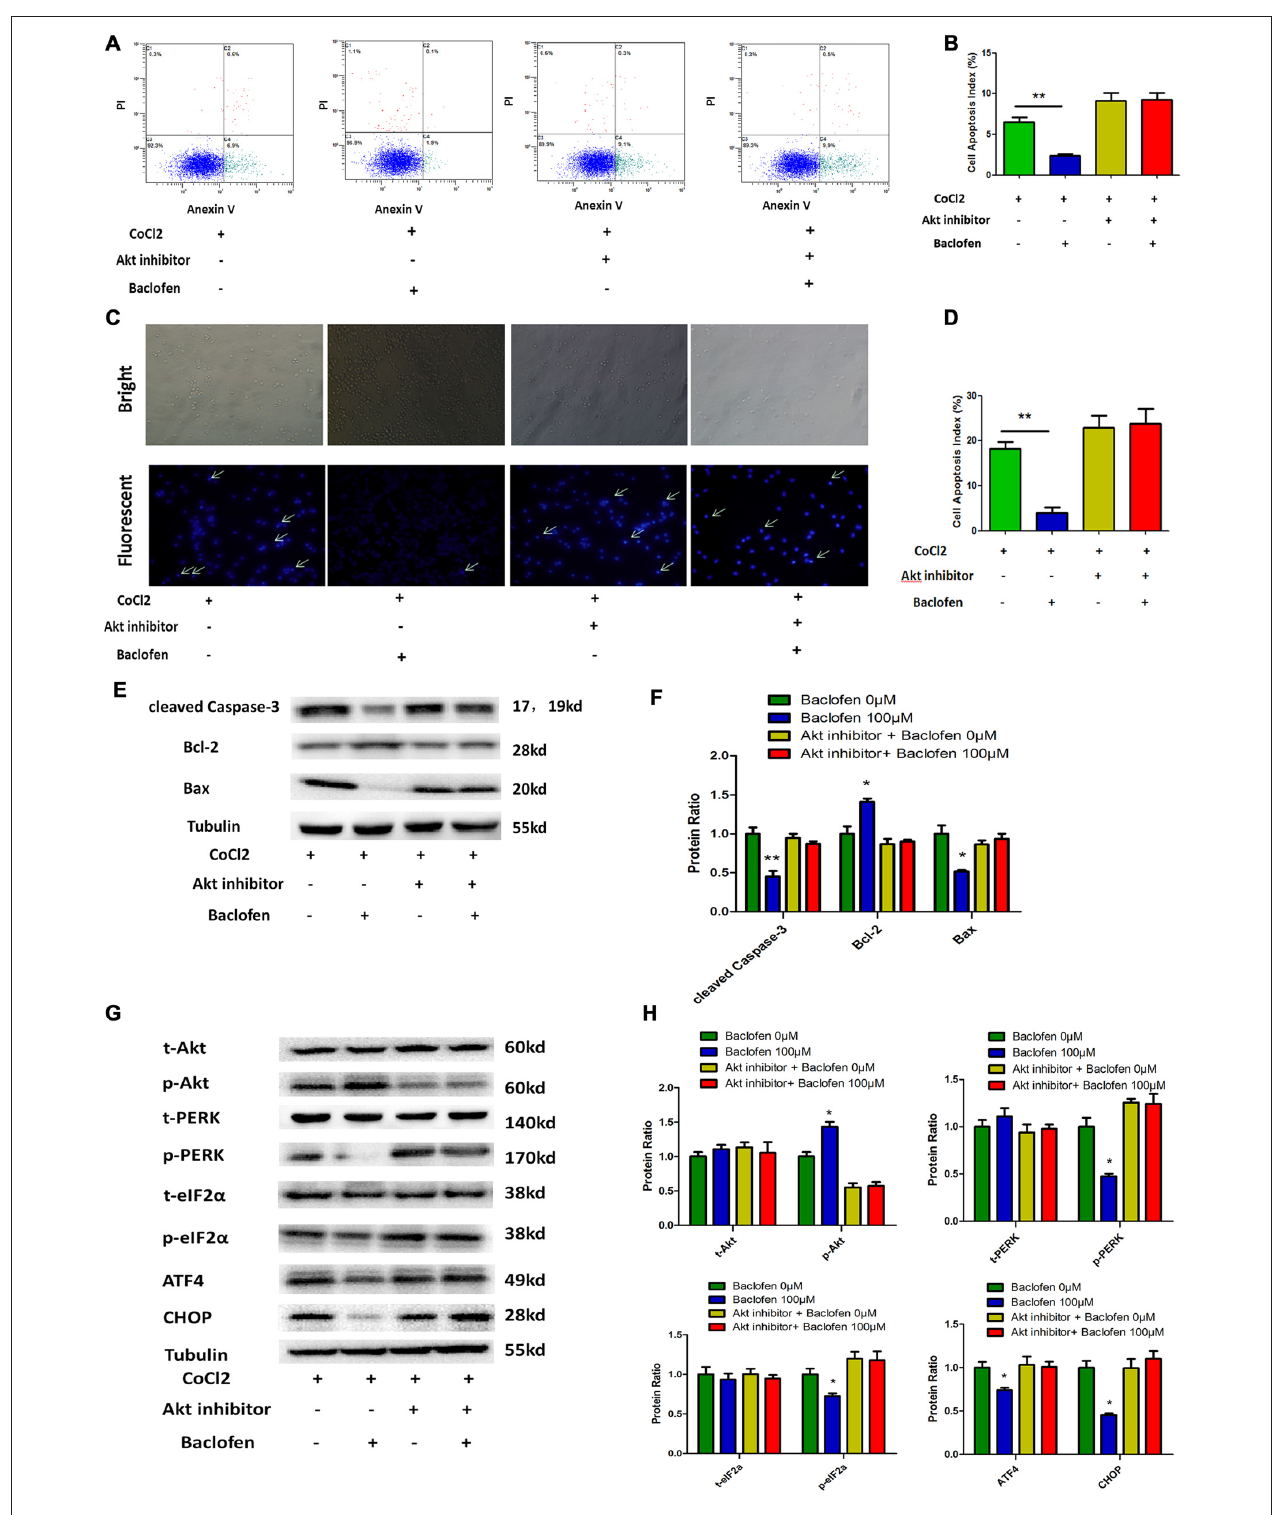
FIGURE 6 | Akt phosphorylation is needed for baclofen mediating RGCs apoptosis. (A,B) Cell apoptosis detected by Annexin V and PI staining methods in RGCs treated with CoCl 2 , baclofen and Akt inhibitor for 24 h as indicated. C4 quadrant (Annexin V + /PI − ) indicates the percentage of apoptotic cells. Values represent the mean ± SD of three independent experiments. ∗∗ P < 0.01 vs. basal level. (C,D) RGCs stained with Hoechst nuclear stain after treatment as